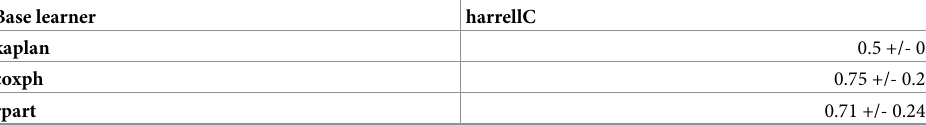
Performance of the cox proportional hazards, Kaplan-Meier, and random forest survival models by 5 fold cross- validation using Harrell’s C (harrellC) as the model performance metric. The median 5-fold cross-validation results are shown +/- MAD. Base learner refers to the type of machine learning model used in the pipeline including kaplan (Kaplan-Meier), coxph (cox proportional hazards), or rpart (tree based survival